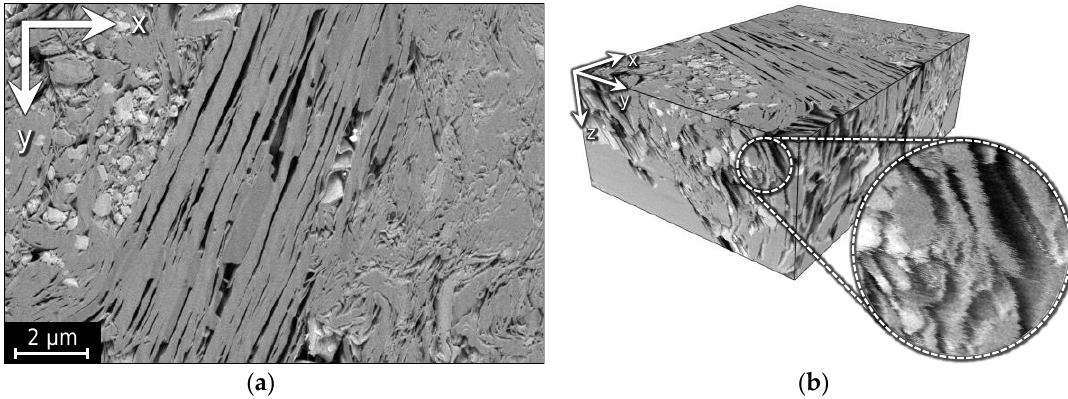
Figure 3. Image A: ( a ) a slice in the XY-plane; ( b ) 3D visualization and enlarged fragment of its side demonstrating misalignment in the XY-plane, which looks like shifted rows and ragged edges in the XZ and YZ side views.